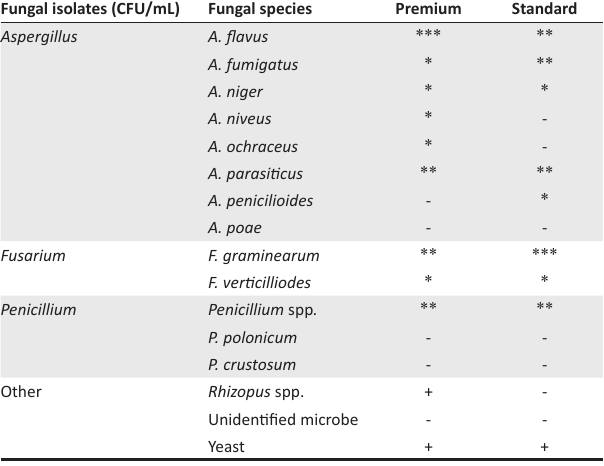
TABLE 2: Fungal identification and their approximate quantitation (colony forming units) in premium brands and standard brands feeds after culture. Fungal isolates